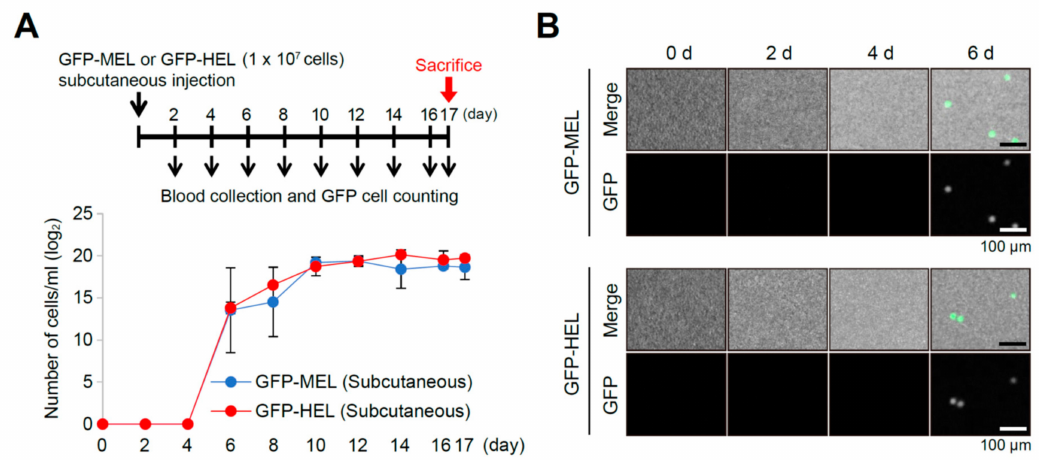
Figure 3. Analysis of circulating MEL or HEL cells by tail vein injection to validate applicability for tumorigenic level. ( A ) Scheme of blood collection by eye bleeding for 14 or 19 days after GFP-expressing MEL or HEL cell transfusion, respectively. ( B ) Representative Arthur ™ (NanoEnTek Arthur TM , Seoul, Korea) histograms show the green fluorescence intensities and counts for the GFP-expressing MEL or HEL cell. ( C ) Quantification of collected circulating GFP-positive MEL or HEL cells at every 2 days after transfusion for 14 (HEL cells) or 19 days (MEL cells; additional 2-day cultivation after euthanization) that showed stable cell numbers in blood stream at 48 h after